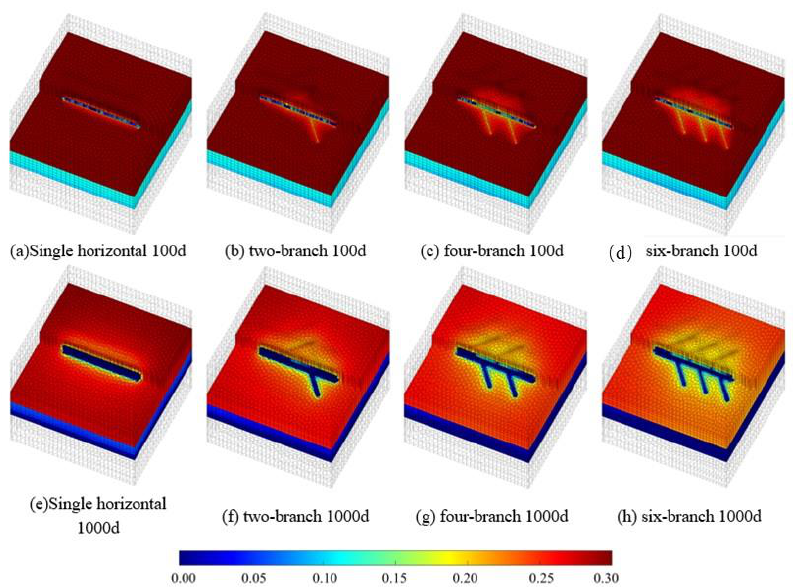
Figure 7. Temperature field in depressurized development of fishbone well with different number of branches.